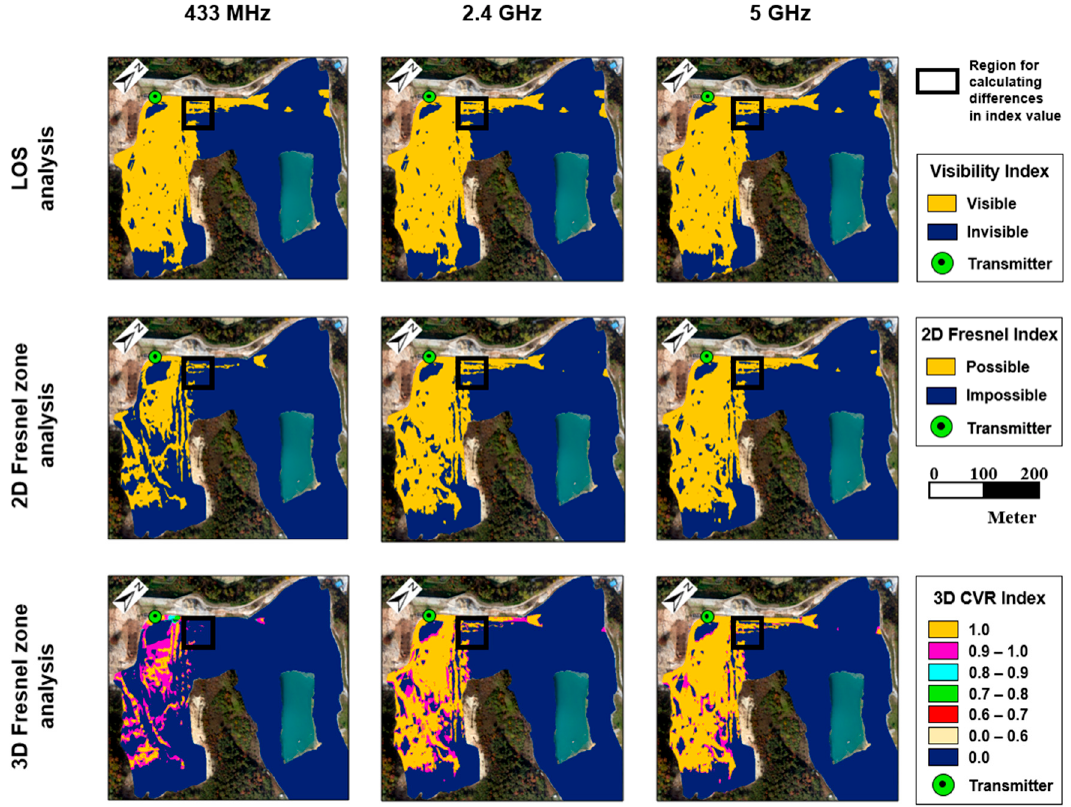
Figure 10. Index maps for transmitter 1 generated by each method for a transmitter offset height of 3 m and frequency thresholds of 433 MHz, 2.4 GHz, and 5 GHz.